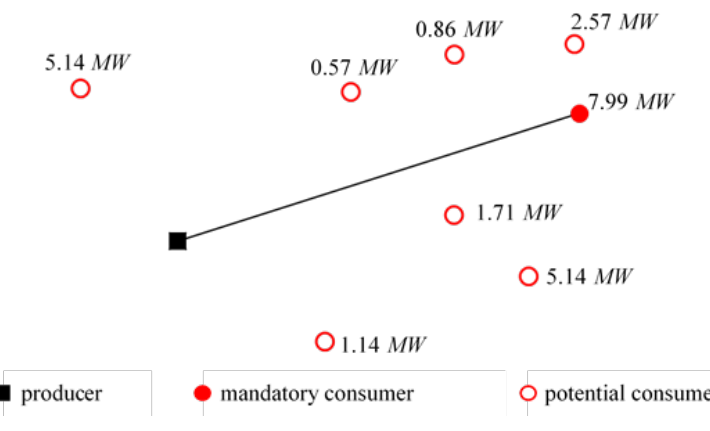
. Ex loss . Figure 7. DHN topology for min Figure 7. DHN topology for min 𝐸̇𝑥 𝑙𝑜𝑠𝑠 . Table 6. Values of 𝑃𝑟𝑜𝑓𝑖𝑡 and 𝐸̇𝑥 𝑙𝑜𝑠𝑠 for the three different studied cases. For each case, the value of optimized criteria is in bold.